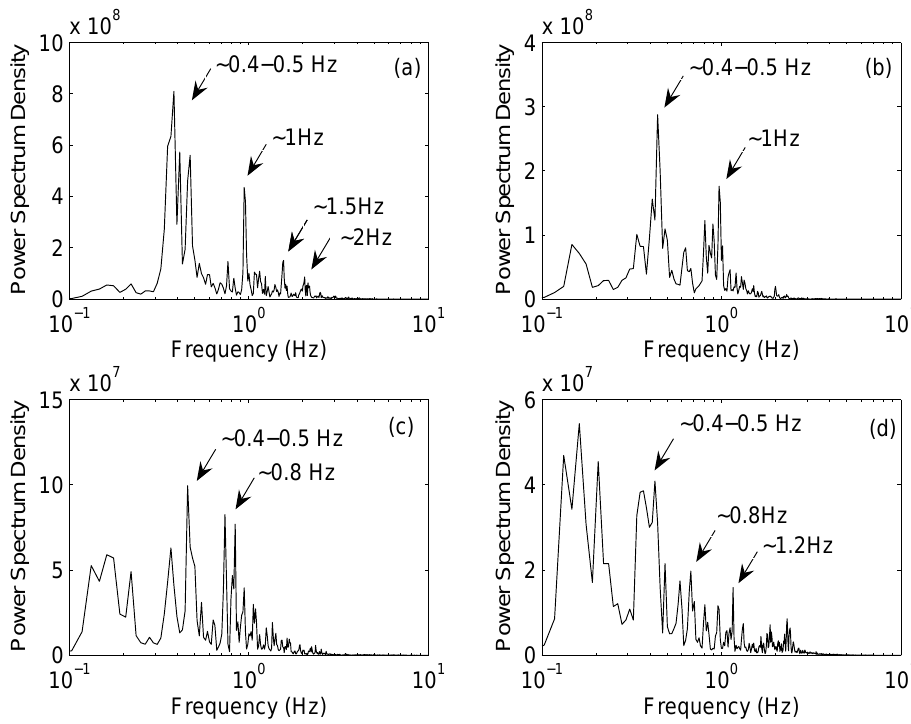
Fig. 11. Stacked power spectrum of LP events of Colima volcano at (a) COCA, (b) COME, (c) COBA, (d) COTE (from De Lauro et al., 2011). The x-axis is in log-scale. Arrows highlight the principal